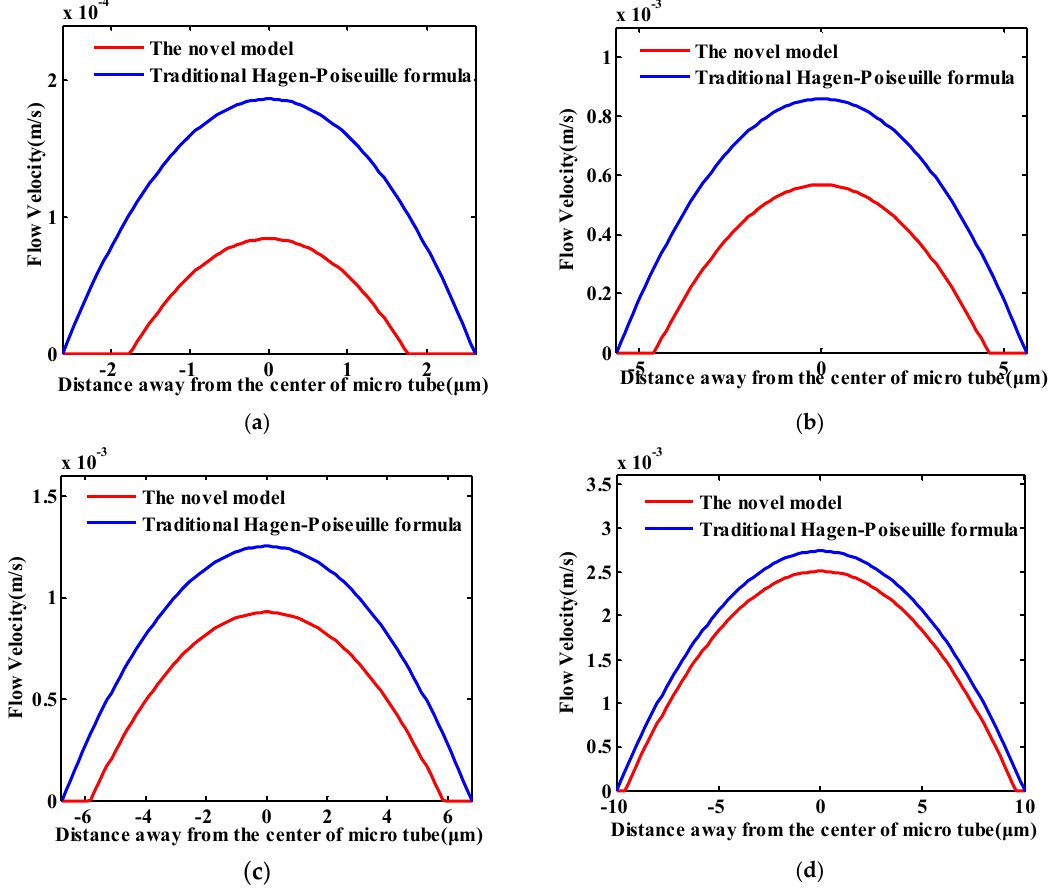
Figure 10. Velocity profile in different radial micro tubes : ( a ) R = 2.62 μ m; ( b ) R = 5.62 μ m; ( c ) R = 6.79 μ m; ( d ) R = 10.03 μ m.